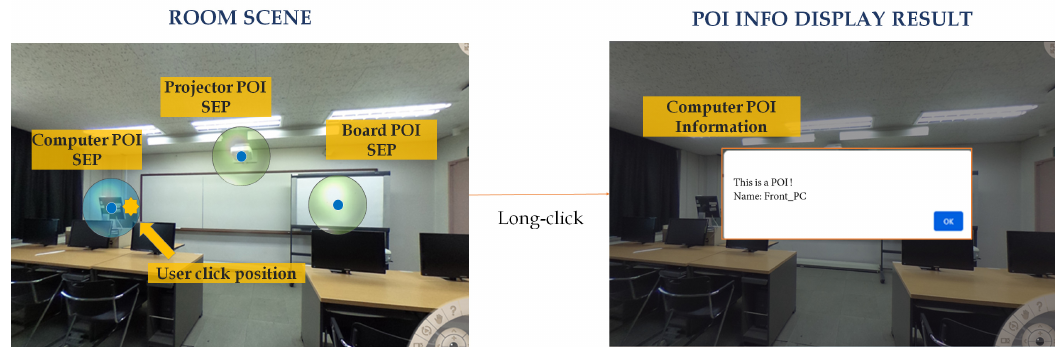
Figure 15. Detecting the indoor features on the images through the SEP method.